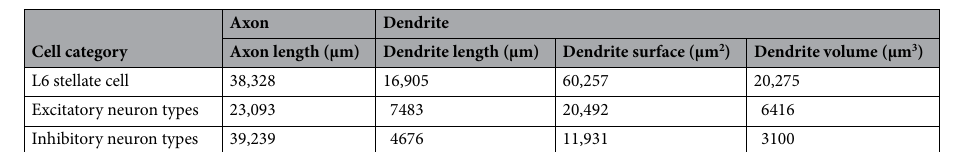
Table 2. Comparison between basic parameters of L6SC and other neuron types in V1. Comparison between morphological parameters of L6SC with those of previously reconstructed excitatory (L2/3 pyramidal neurons, n = 9 19 ; L4 spiny stellate and star-pyramidal neurons, n = 18 20 ; L6 pyramidal neurons, n = 26 21 ) and GABAergic L3–L4 (basket cells, n = 12 59,60 ) neuron types. The L6 stellate neuron has the longest dendritic length (> 2 times) and the largest dendritic surface/volume ratio (> 3 times) compared with any other types published so far. The table displays numerical values for each neuron category.